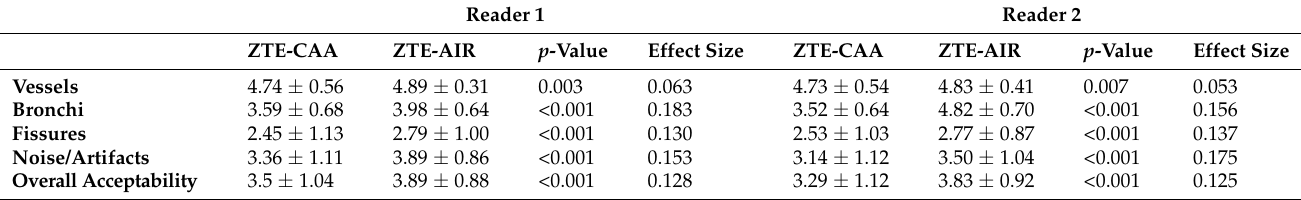
Table 3. Subjective image quality of ZTE-CAA and ZTE-AIR by two independent readers ( n = 66). Reader